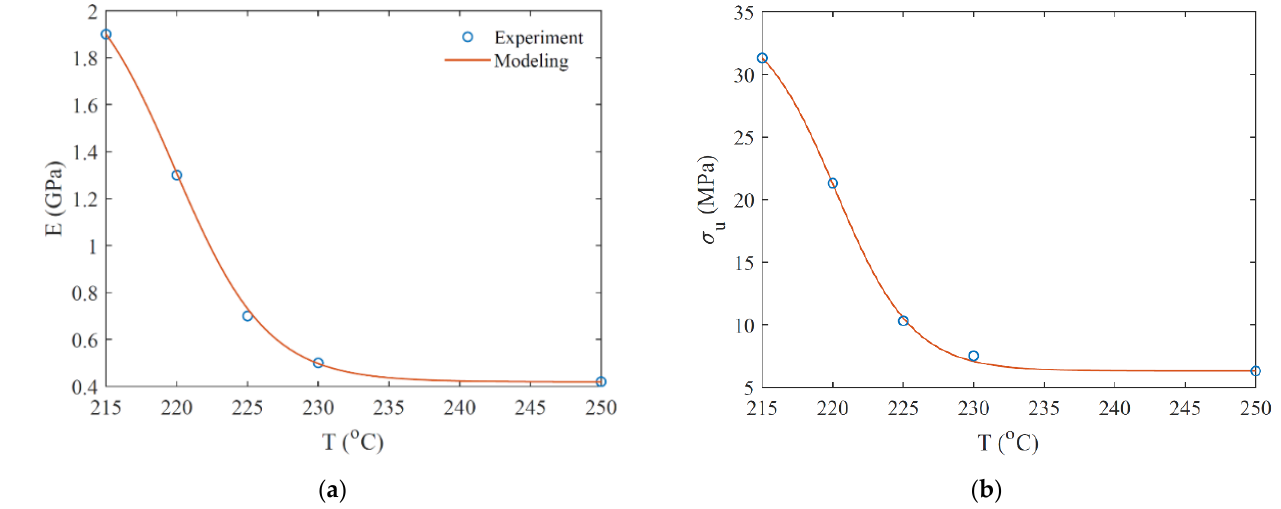
Figure 5. Young modulus ( a ) and ultimate strength ( b ) of PLA printed sample at different printing temperatures.